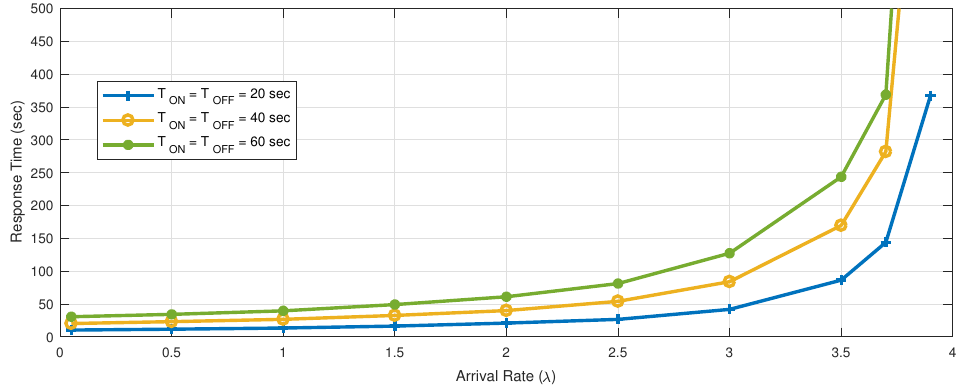
Figure 5. Response time for various T ON , T OFF